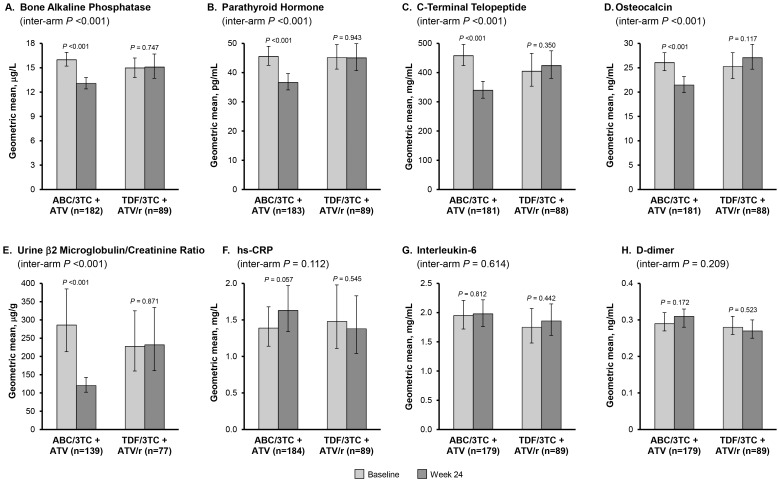
Biomarkers.Geometric means and 95% confidence intervals for bone (bone alkaline phosphatase, parathyroid hormone, C-terminal telopeptide and osteocalcin), renal (urine β2 microglobulin/creatinine ratio), and inflammatory (high sensitivity C-reactive protein [hs-CRP], interleukin-6, and d-dimer) biomarkers in patients in both treatment groups with data at baseline and Week 24. Intra-arm P-values were calculated using a paired t-test on the ratio of the geometric mean concentration at baseline and the geometric mean concentration at Week 24. Inter-arm P-values were calculated using a two sample t-test on the ratio of the geometric mean change from baseline to Week 24 in the ABC/3TC+ATV vs. TDF/FTC+ATV/r groups.